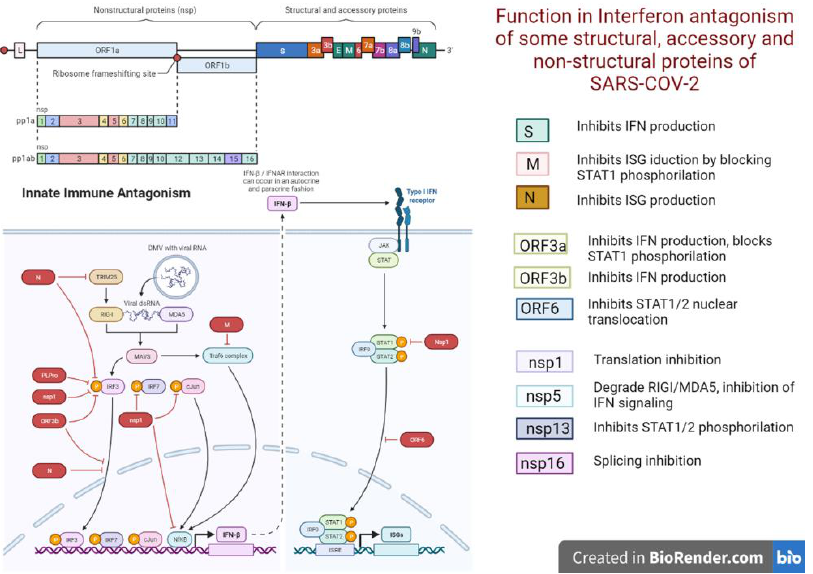
Figure 7. Ways SARS-CoV-2 proteins block interferon signaling.